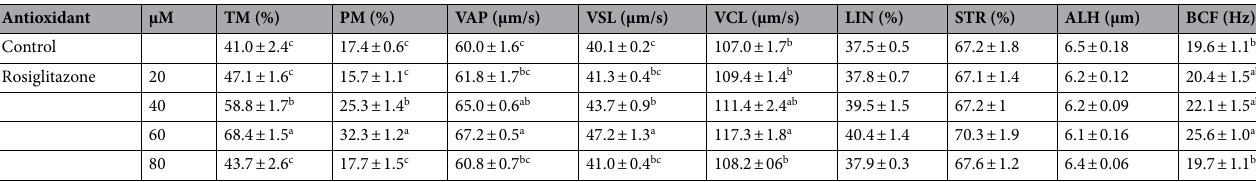
Table 1. Results of the motility analysis (CASA). TM total motility, PM progressive motility, VSL curvilinear velocity, VAP average path velocity, VSL straight-line velocity, LIN linearity, STR straightness, ALH amplitude